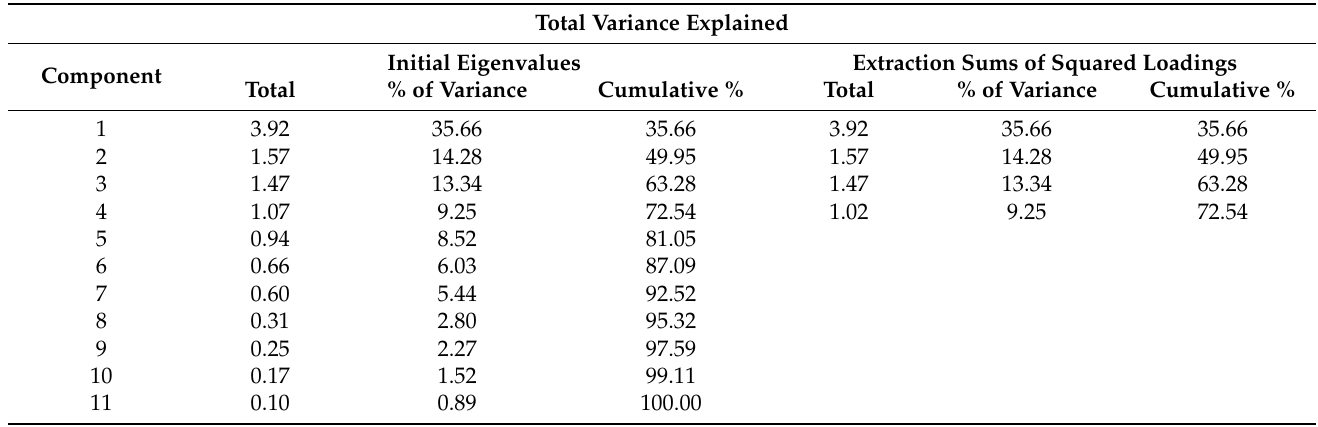
Table 3. Explained total variance with principal component